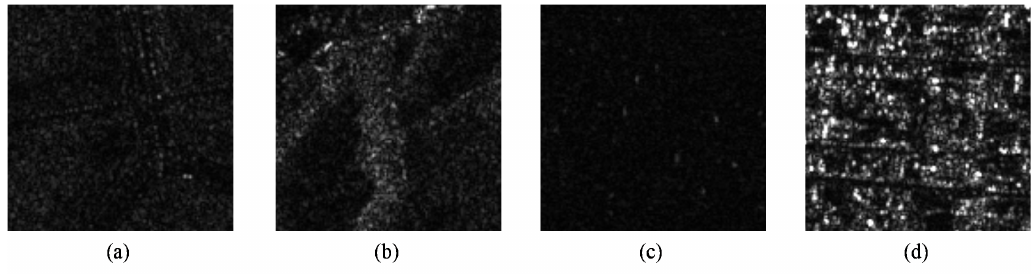
Figure 4. Different types of SAR scene images. ( a ) cultivated lands; ( b ) mountains; ( c ) rivers; ( d ) cities.